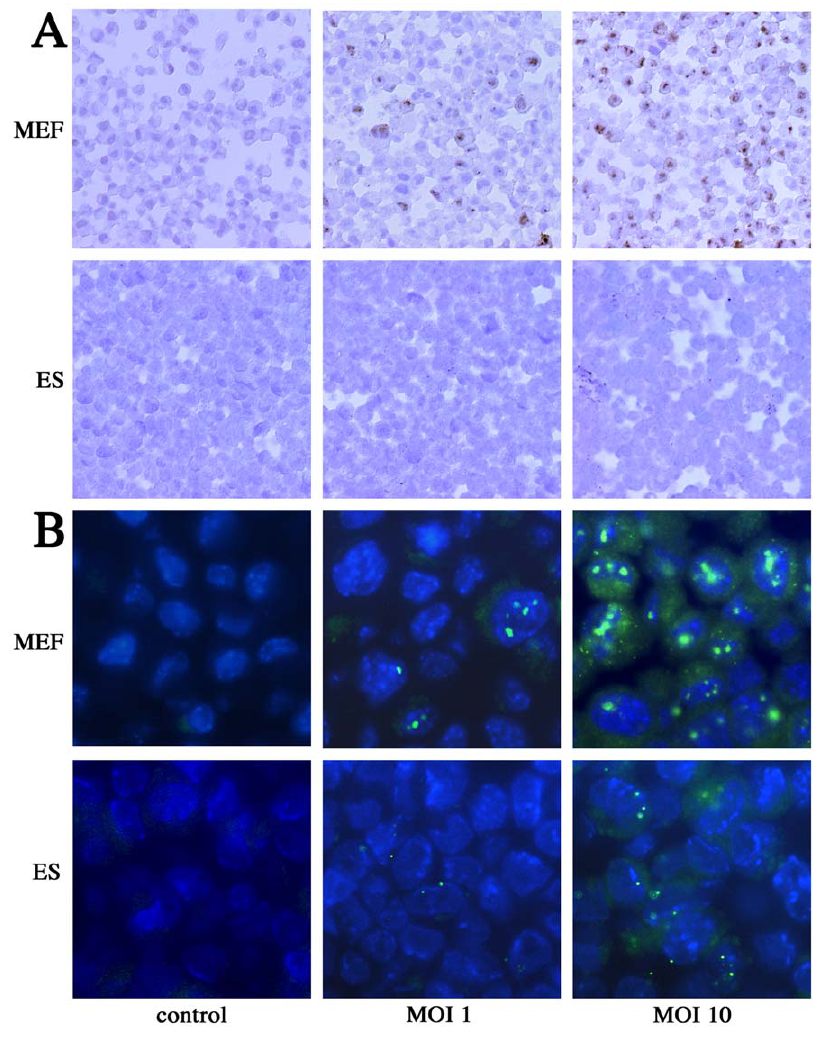
Figure 8. Visualization of the MCMV genome by insitu hybridization in MEF and ES cells. To confirm the results of the DNA quantification experiments, in situ hybridization was used to visualize the MCMV genome in MEF and ES cells infected with MCMV at MOIs of 1 and 10. The DNA was visualized by (A) immunostaining with DAB (brown) or by a (B) GFP signal (green).